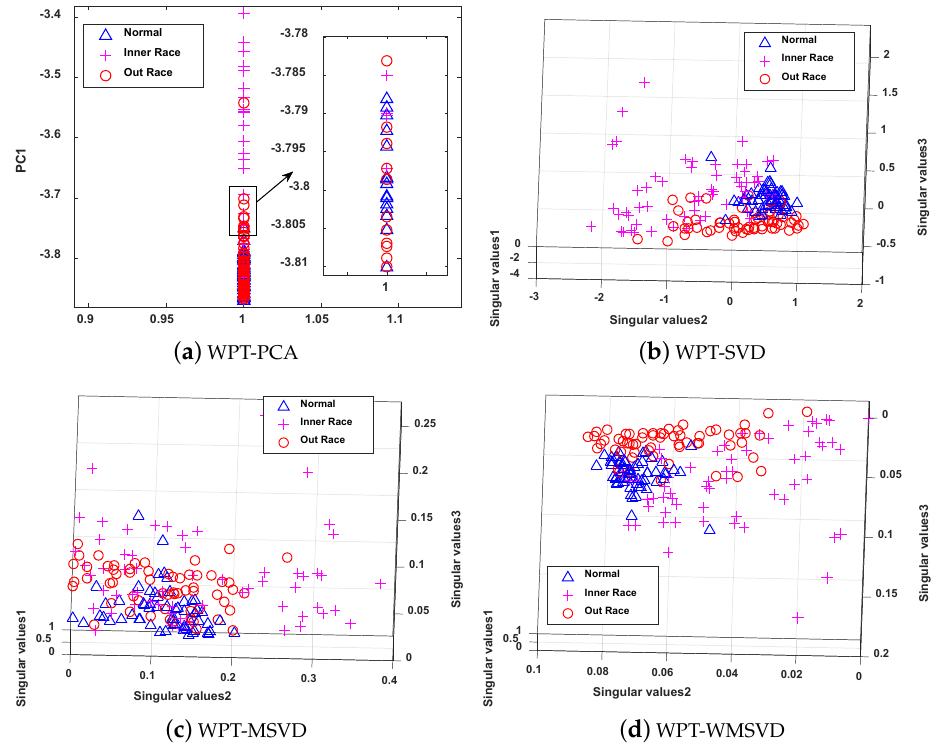
Figure 11. The Visualization of feature extraction effect of four methods: ( a ) Distribution of the data samples based on WPT-PCA; ( b ) Distribution of the data samples based on WPT-SVD; ( c ) Distribution of the data samples based on WPT-WSVD; ( d ) Distribution of the data samples based on WPT- MWSVD.